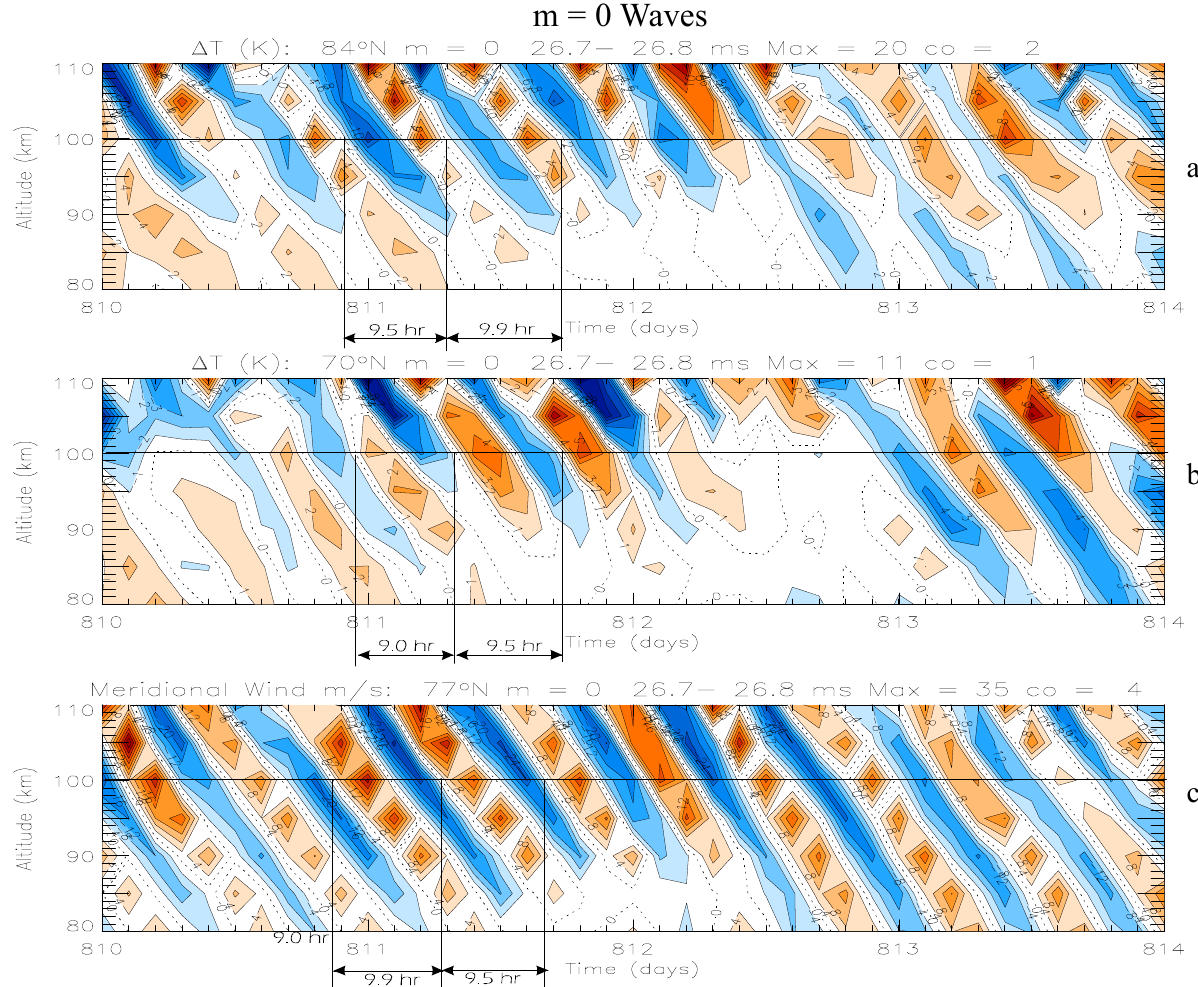
Fig. 2. Similar to Fig. 1 but for m=0 temperature variations at 84 ◦ N ( a ) and 70 ◦ N ( b ) and related meridional winds at 77 ◦ N ( c ) . The contour intervals are 2K (a), 1K (b) and 4m/s